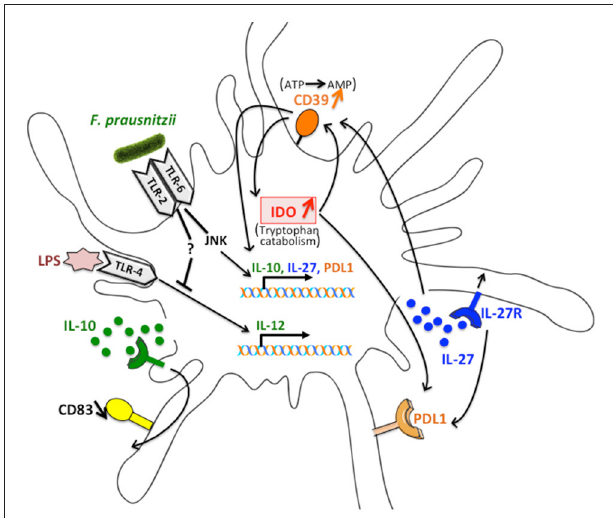
FIGURE 8 | Schematic representation of the interactions involved in the alteration of DC function following exposure to F. prausnitzii . IL-27 secretion induced by F. prausnitzii in a JNK dependent manner up-regulates CD39 expression. The ENTPDase activity of CD39 then contributes to IL-10 and IL-27 induction and up-regulates IDO1, in a feed-forward loop. IL-10 secretion also induced via the TLR2/6/JNK pathway limits the LPS-induced expression of CD83, which is affected by TLR2/6 triggering but not JNK blocking. Finally, PDL-1 expression relies on IDO1 enzymatic activity and, partly, on JNK and IL-27